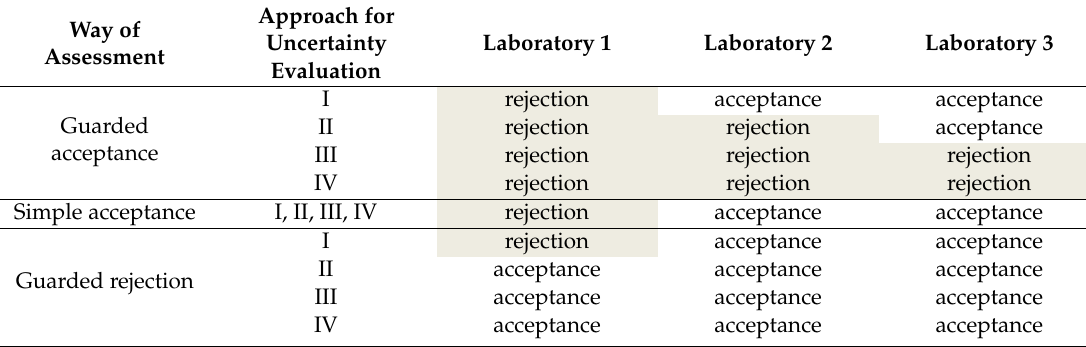
Table 4. Decisions about rejection or acceptance of the adhesive used for bonding of insulation material to a wall, depending on the laboratory approach used for uncertainty evaluation and the way of using uncertainty in assessment (based on the example of the “n”